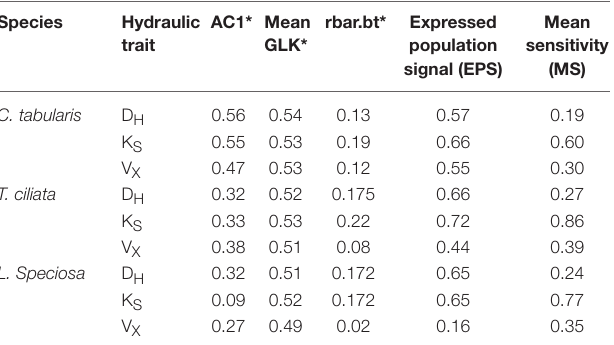
TABLE 2 | Chronology characteristics of three hydraulic traits for three South Asian moist tropical forest tree species. Species Hydraulic